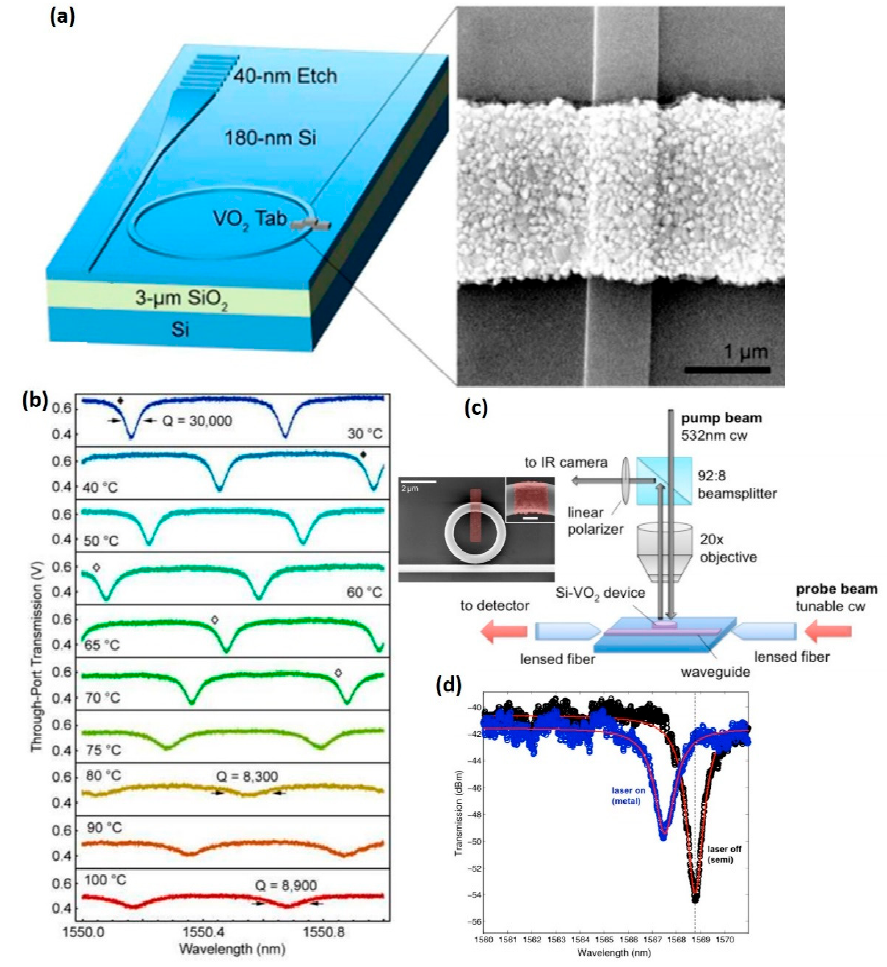
Figure 9. Photonic modulators and switches using VO 2 as the PCM. ( a ) Schematic of VO 2 modulator consisting of a grating coupler, a silicon bus waveguide, and a silicon ring resonator covered with a strip of VO 2 . The SEM image of the VO 2 patch straddling the waveguide is shown on the right. ( b ) Transmission spectra of the through port at increasing temperatures for the schematic presented in ( a ). The modes of the same azimuthal order are indicated with diamond-shaped markers. These markers show a temperature-dependent red-shift. ( c ) Schematic of the measurement setup of a VO 2 -based optical modulator. The SEM image of the modulator is shown in the inset. ( d ) Optical transmission from the setup given in ( c ) before and after the trigger. The spectra show a blue-shift upon exposure to the trigger. (( a , b ) reproduced under creative commons license [142]; ( c , d ) reproduced under creative commons license [143]).